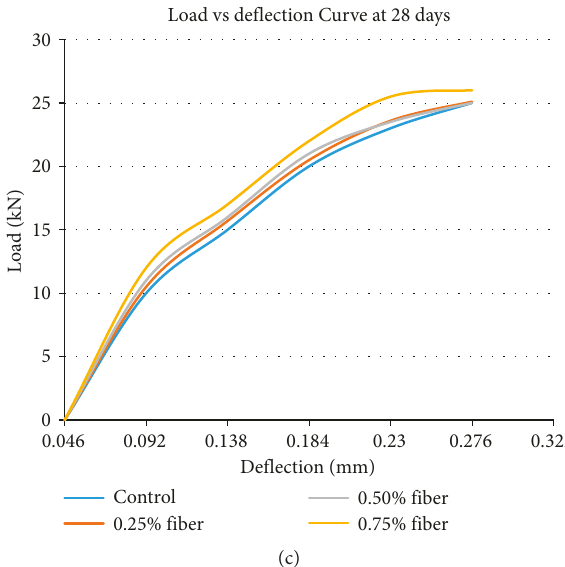
Figure 9: (a) Average load verses deflection comparison of set I beams at 7days, (b) average load verses deflection comparison of set I beams at 21days, average load verses deflection comparison of set I beams at 28 days.